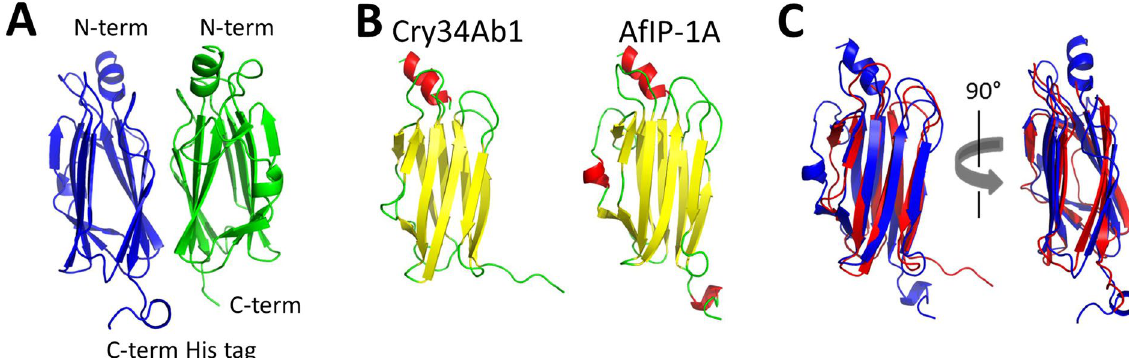
Figure 4. Structure model of AfIP-1A(I20M, T135M) compared to Cry34Ab1 ( A ) X-ray crystal structure of AfIP-1A (PDB ID: 5V3S). Each monomer in the dimer is distinguished by color. ( B ) Structures of Cry34Ab1 (PDB ID: 4JJOX) and AfIP-1A monomer. ( C ) Overlay of Cry34Ab1 (red) with Af1P-1A